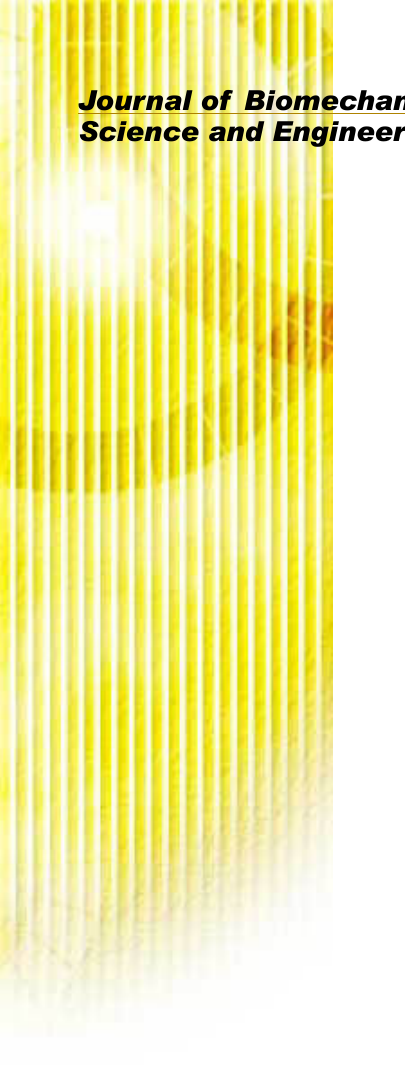
/ l during computation sp3 sp3,0